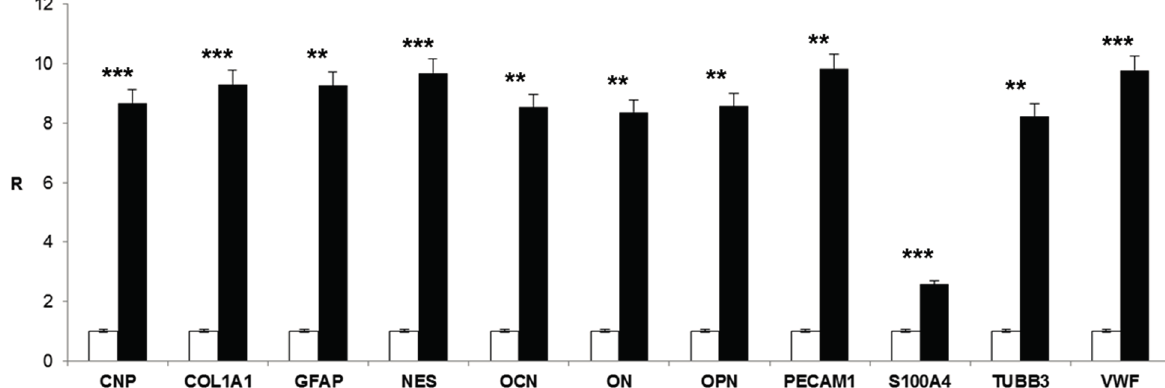
Figure 3. Gene expression profile of endothelial markers (Von Willebrand factor (VWF), platelet/endothelial cell adhesion molecule 1 (PECAM1)), osteo/odontoblast-related markers (osteocalcin (OCN), osteonectin (ON), osteopontin (OPN), collagen type I (COL1A1)), glial cell markers (glial fibrillary acidic protein (GFAP), 2',3'-cyclic nucleotide 3' phosphodiesterase (CNP)), neuronal markers (nestin (NES), tubulin beta 3 class III (TUBB3)) and stem cell marker S100A4 in DPSCs seeded onto hyaluronan-based scaffolds and cultivated with differentiation medium (black bars) or with basal medium (white bars) for 21 days. Significant differences between DPSCs in differentiation medium and DPSCs in basal medium ( ** p < 0.01; *** p < 0.001); R: relative